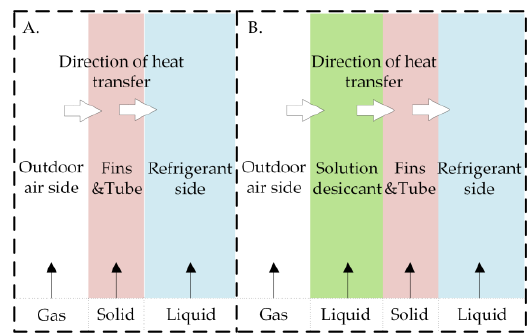
Figure 14. Schematic diagrams of two heat transfer modes.